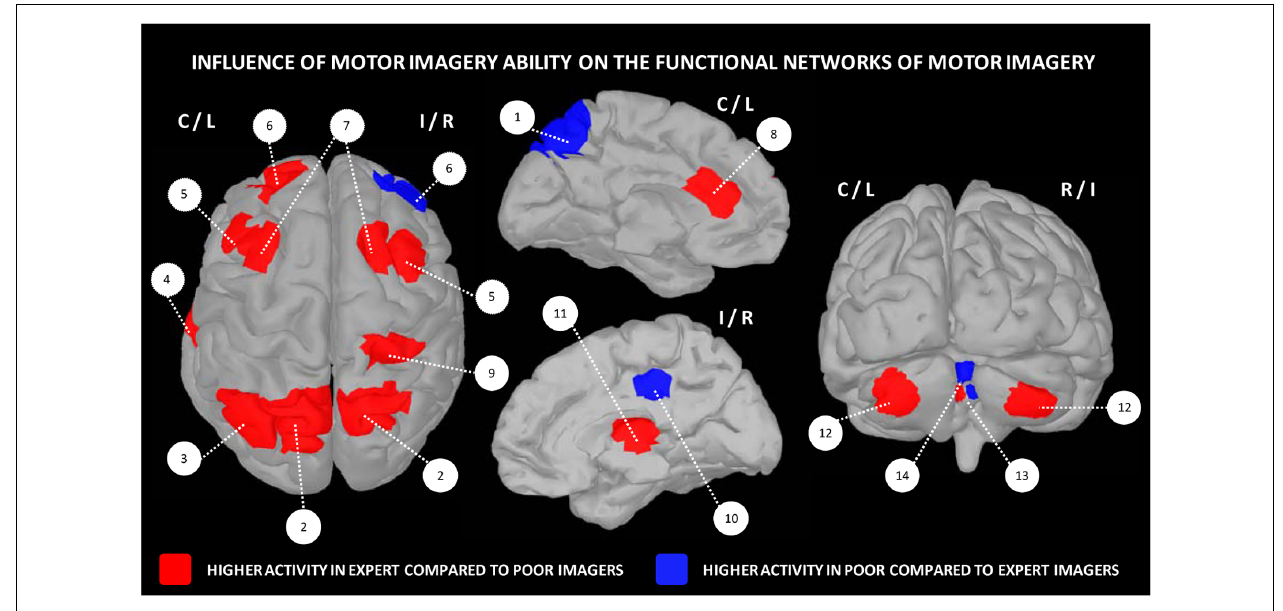
FIGURE 3 | Influence of motor imagery ability on the functional networks underlying motor imagery. 1 – precuneus, 2 – superior parietal cortex, 3 – inferior parietal cortex, 4 – fusiform gyrus, 5 – lateral premotor cortex, 6 – frontal cortex, 7 – dorsal premotor cortex, 8 – anterior cingulate